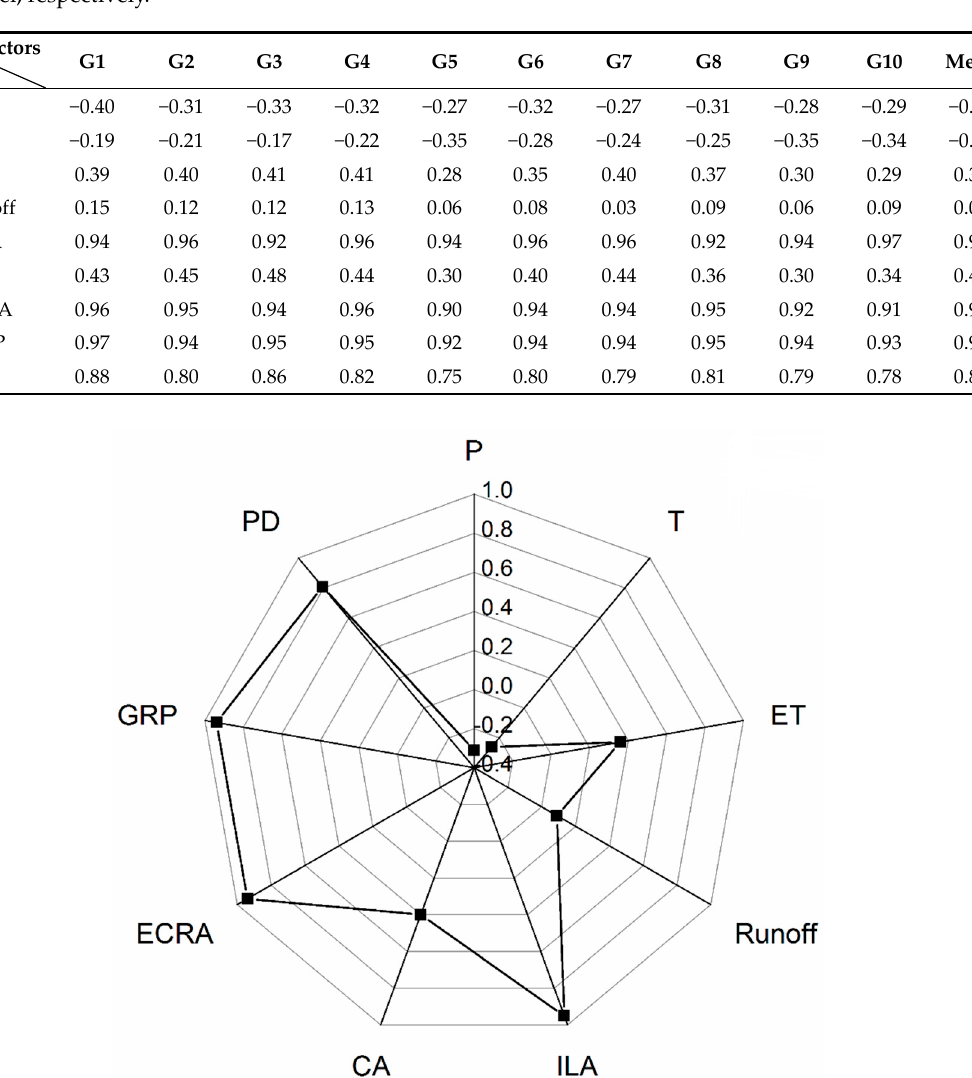
Table 5. Correlation coefficient between the nine factors and the depth of the piezometric groundwater level, respectively.